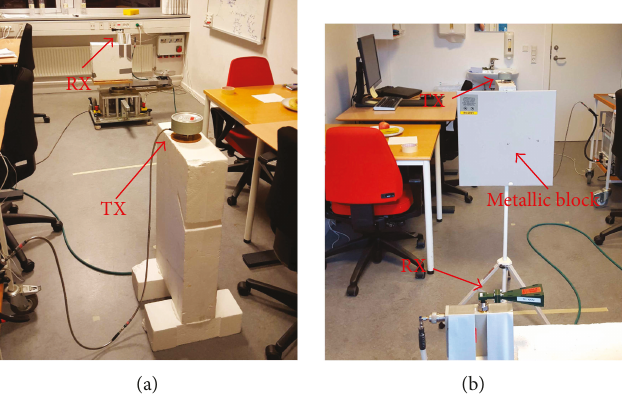
Figure 6: Photograph of the small o ffi ce scenario: Tx view in the LOS scenario (a) and Rx view in the obstructed LOS scenario (b).